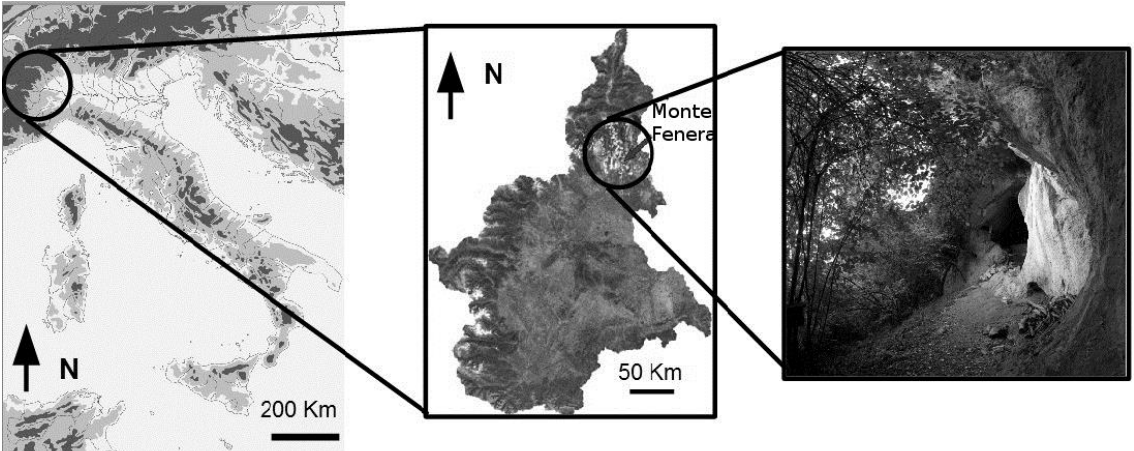
Figure 1. Left and centre: location of Monte Fenera and the Ciota Ciara cave. Right: photo of the Ciota Ciara cave by P.